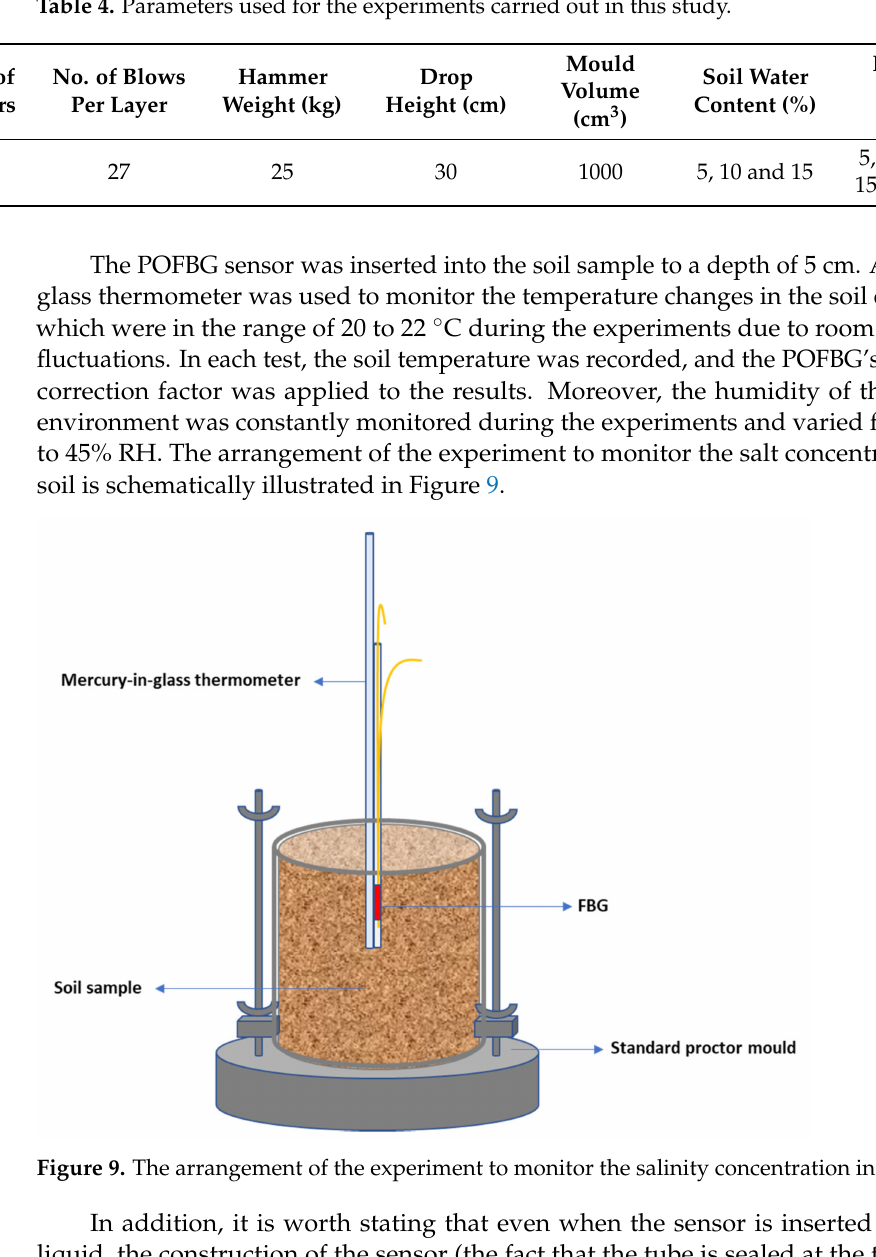
Table 4. Parameters used for the experiments carried out in this study.